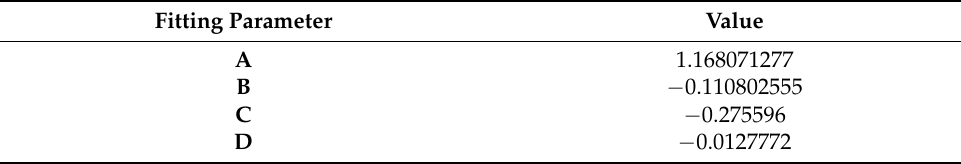
Figure 6. Fitting angle–amplitude (T PS ) data of CTP 63 in the gas channel.